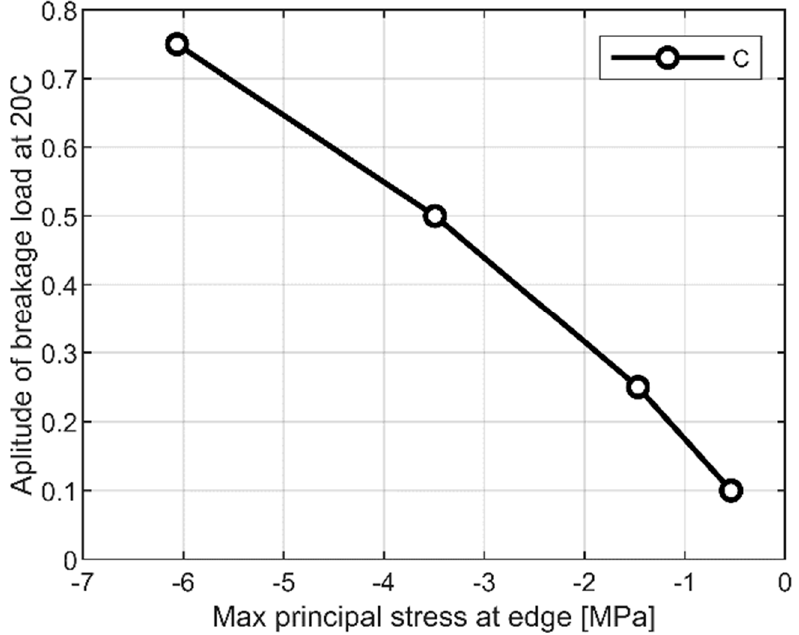
Figure 18. Principal compressive stress at the edge (control point C), as a result of second order effects (ABAQUS/Standard).